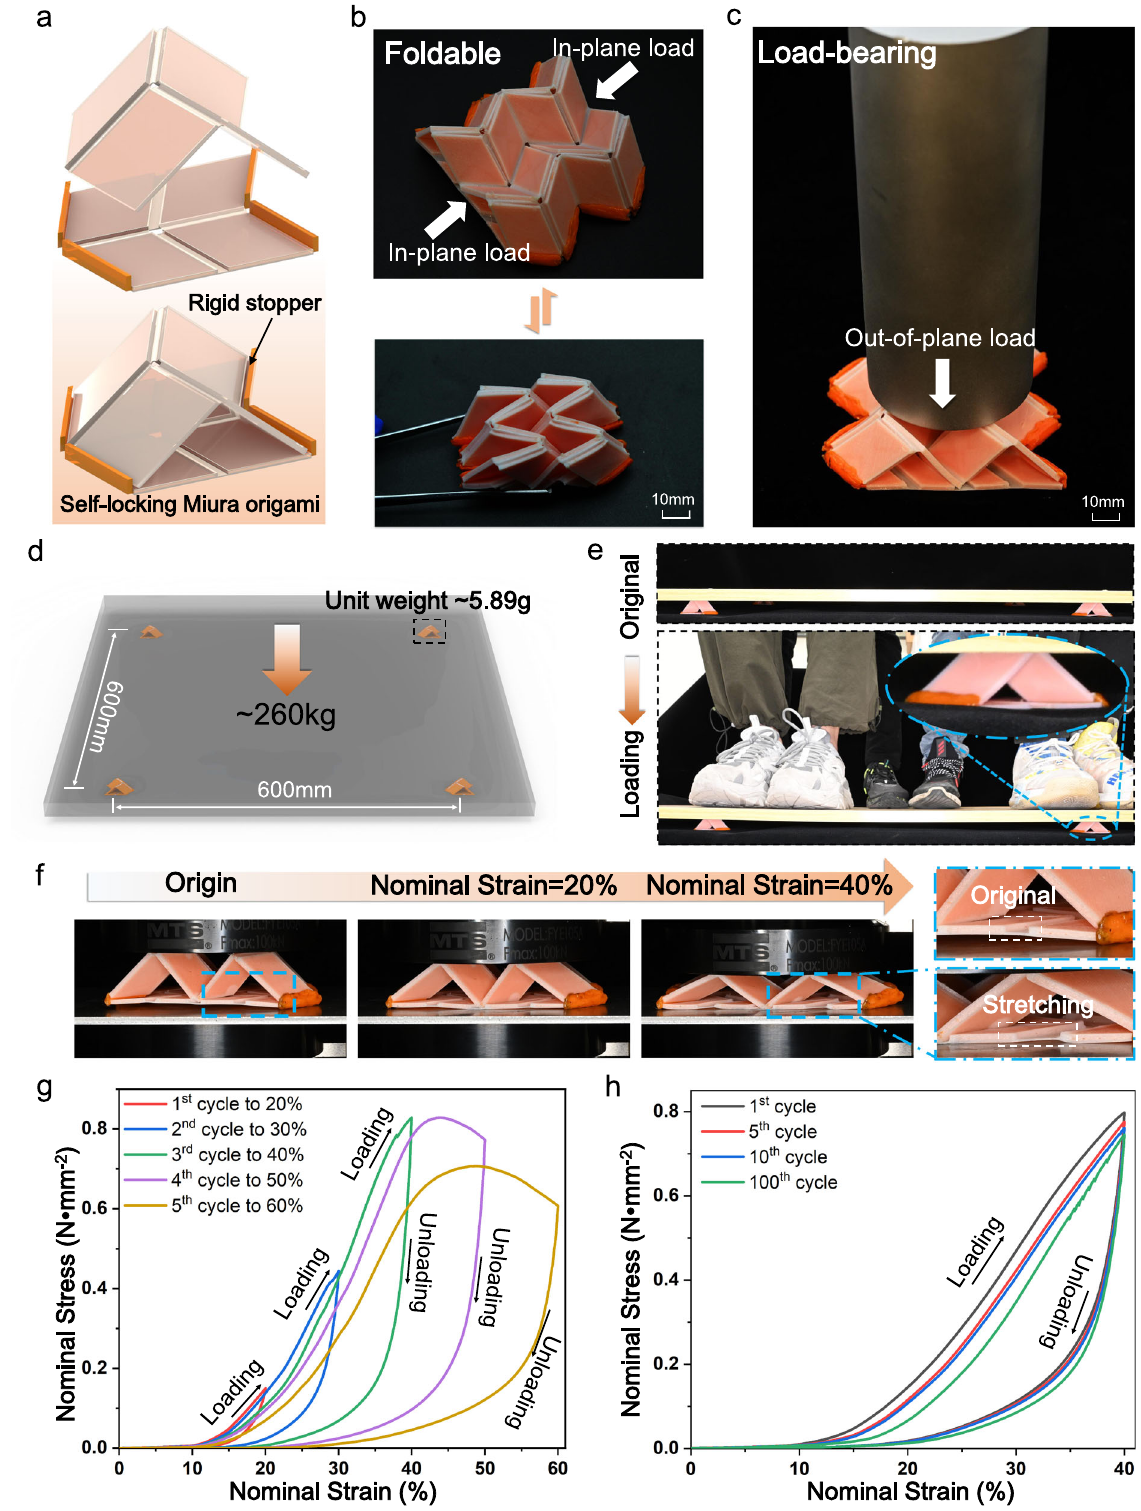
Fig.2|Designandmechanicalperformanceofself-lockingthick-panelorigami. a Assembly of 3D printed fl at thick-panel Miura-origami sheets to achieve self- locking property. b 3Dprintedself-locking thick-panel origami structurewith 2×2 units can be folded along with in-plane direction. c The origami structure can supportaheavyout-of-planeload. d , e Demonstratesthatthick-panelorigamiunits canwithstandaloadover11000timesofitsownweightwithoutfailure. f Snapshots